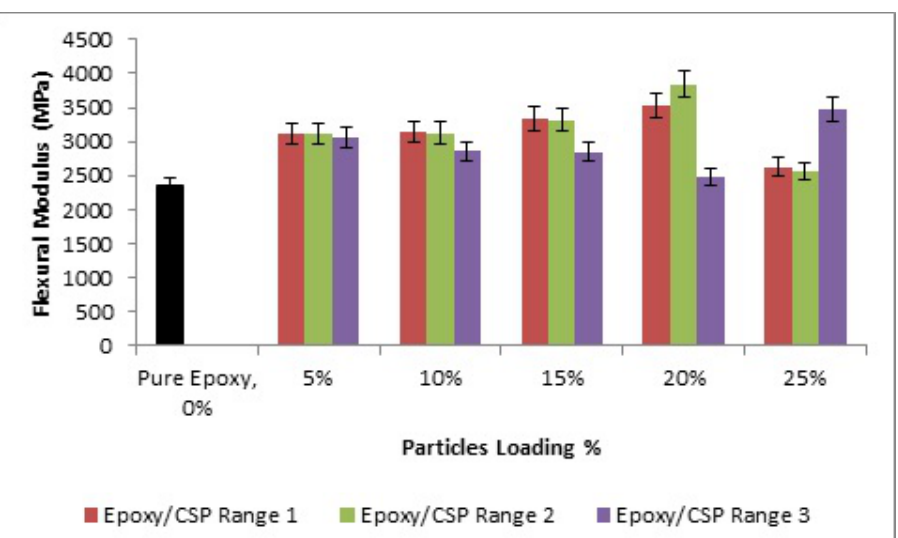
Figure 5: Flexural modulus versus various particles